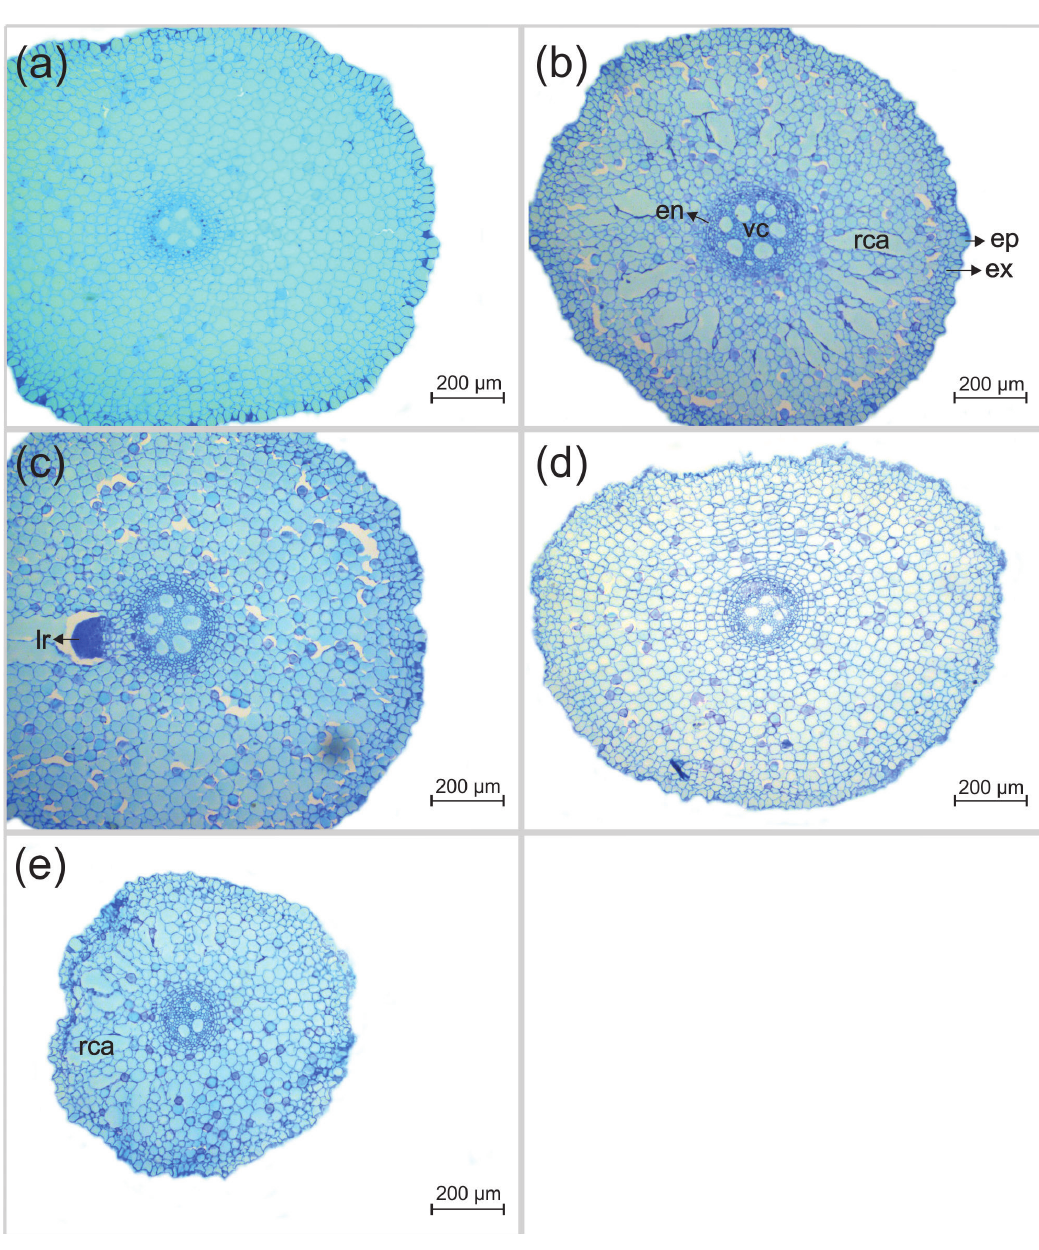
Figure 3. Root anatomical modifications of T. domingensis plants grown under different phosphorus levels on the nutrient solution. (a)= 0.0; (b) = 0.2; (c) = 0.4; (d) = 0.6; (e) = 0.8 mM of phosphorus. ep = epidermis, ex = exodermis, en = endodermis, rca = root cortical aerenchyma, vc = vascular cylinder, lr = lateral